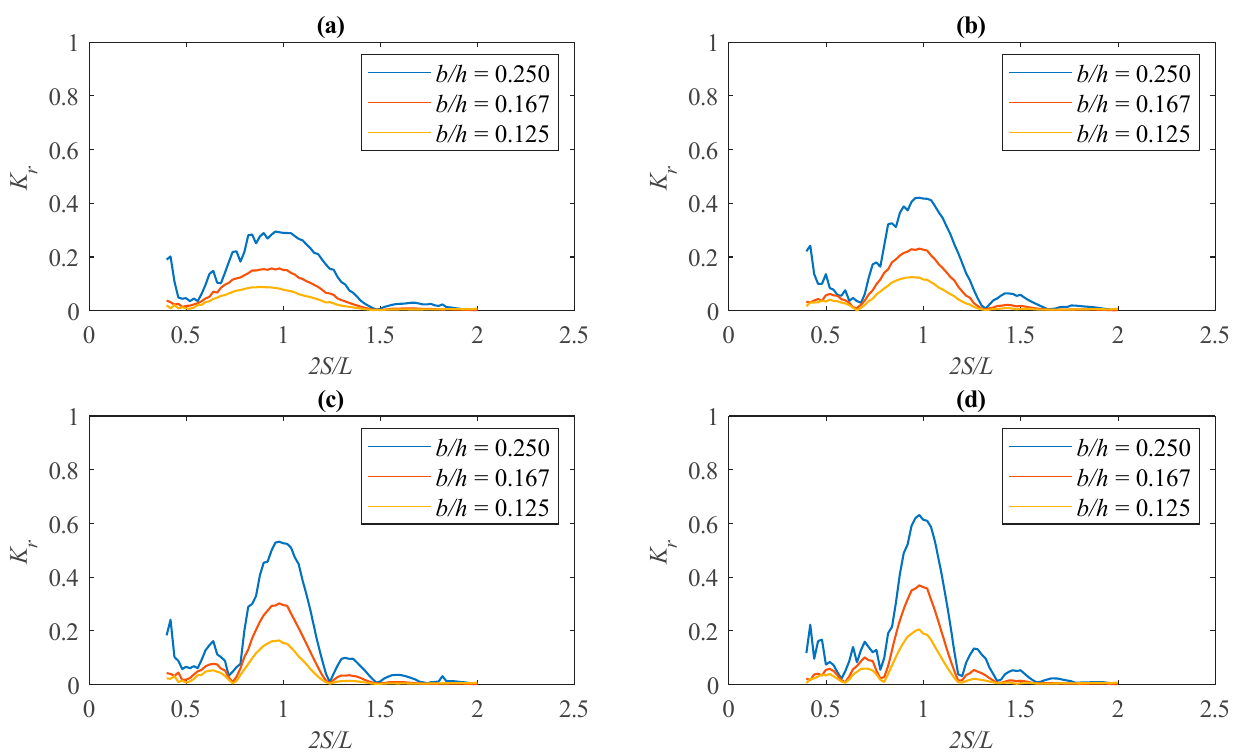
Figure 18. Reflection coefficient of multiple periodically submerged breakwaters with 1.0 m wave- length at different water depths. ( a ) 𝑁 = 2 ( b ) 𝑁 = 3 ( c ) 𝑁 = 4 ( d ) 𝑁 = 5 .